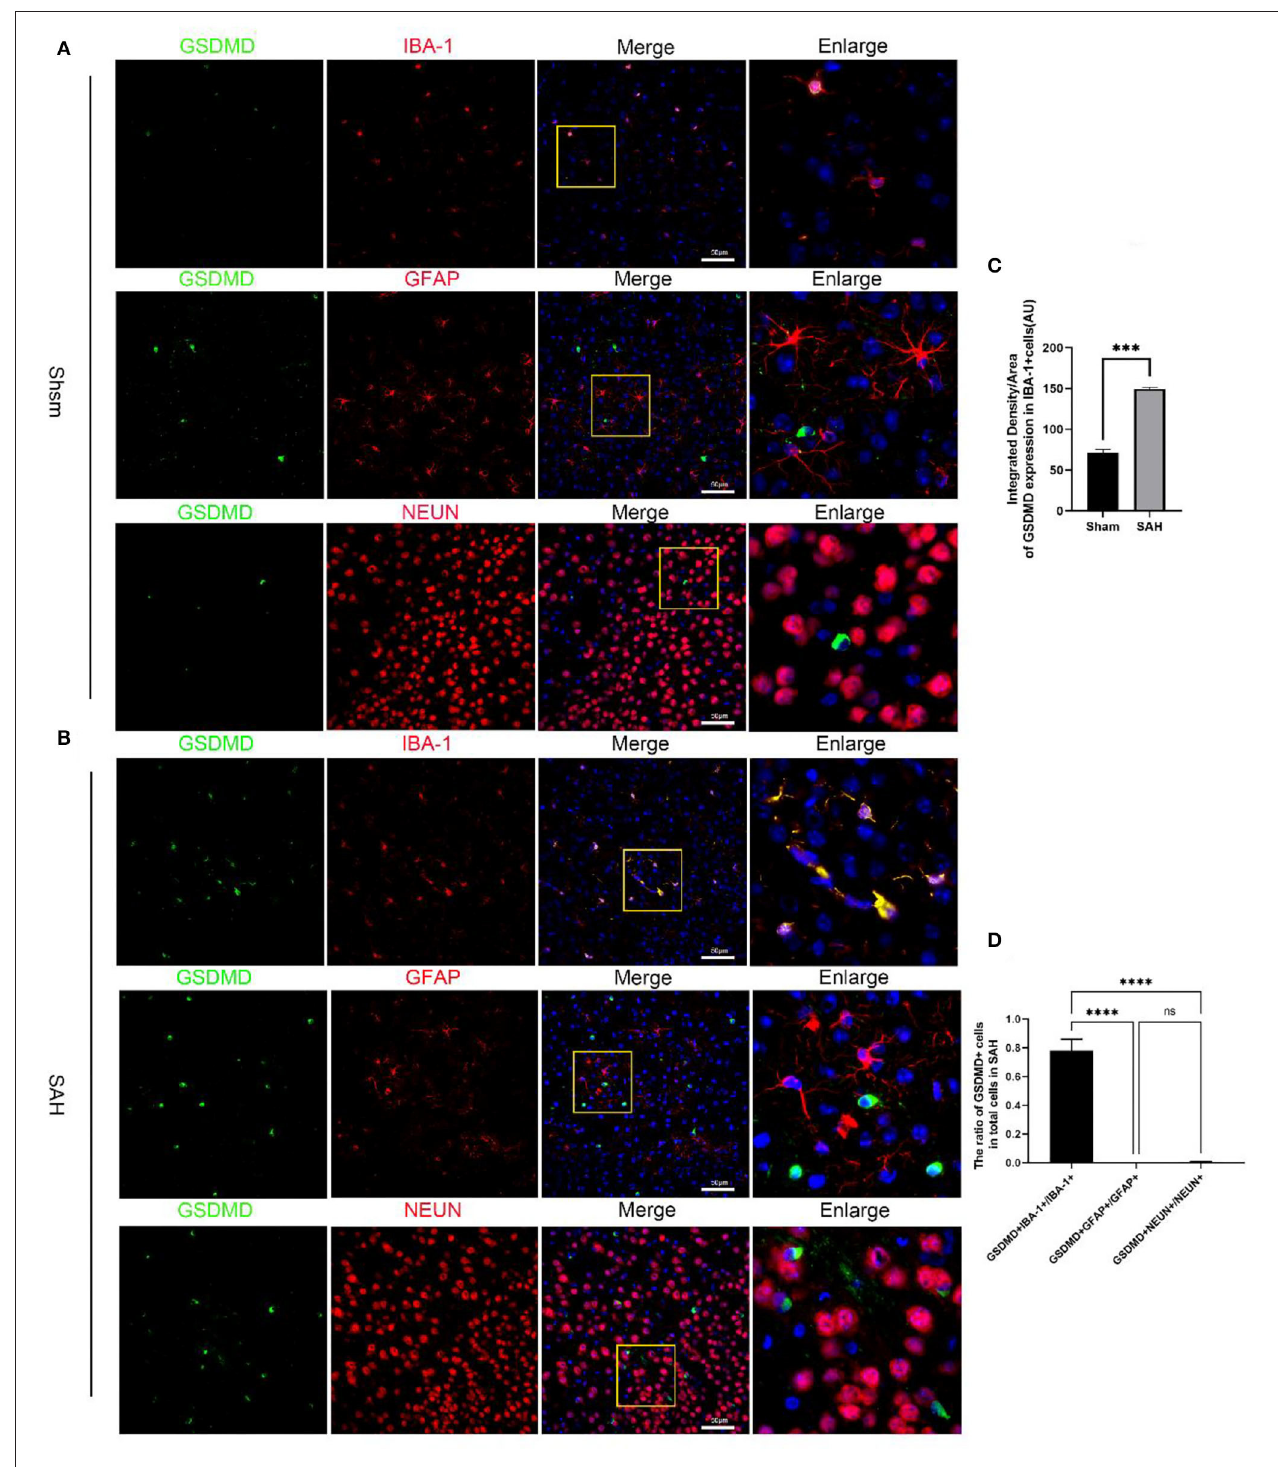
FIGURE 2 | Cellular localization of pyroptosis executioner GSDMD in the ipsilateral hemisphere. (A) Representative immunofluorescence staining slices of GSDMD (green) with microglia (IBA1, red), astrocytes (GFAP, red), and neurons (NEUN, red) in the ipsilateral cortex. (B) Representative immunofluorescence staining slices of GSDMD (green) with microglia (IBA1, red), astrocytes (GFAP, red), and neurons (NEUN, red) in the ipsilateral cortex at 24h after SAH. Scale bars = 50 µ m. (C,D) Quantitative analysis of immunofluorescence staining. All values are presented as means ± SD, n = 6 in each group. *** p < 0.001 and **** p < 0.0001.